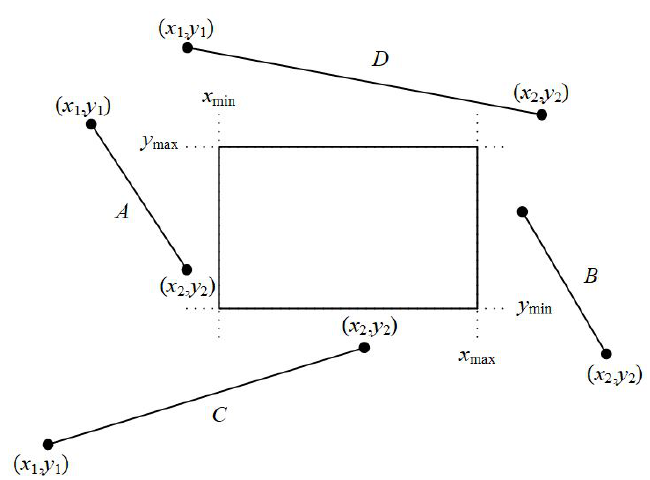
Figure 23. Lines A , B , C and D are rejected according to the first step of the